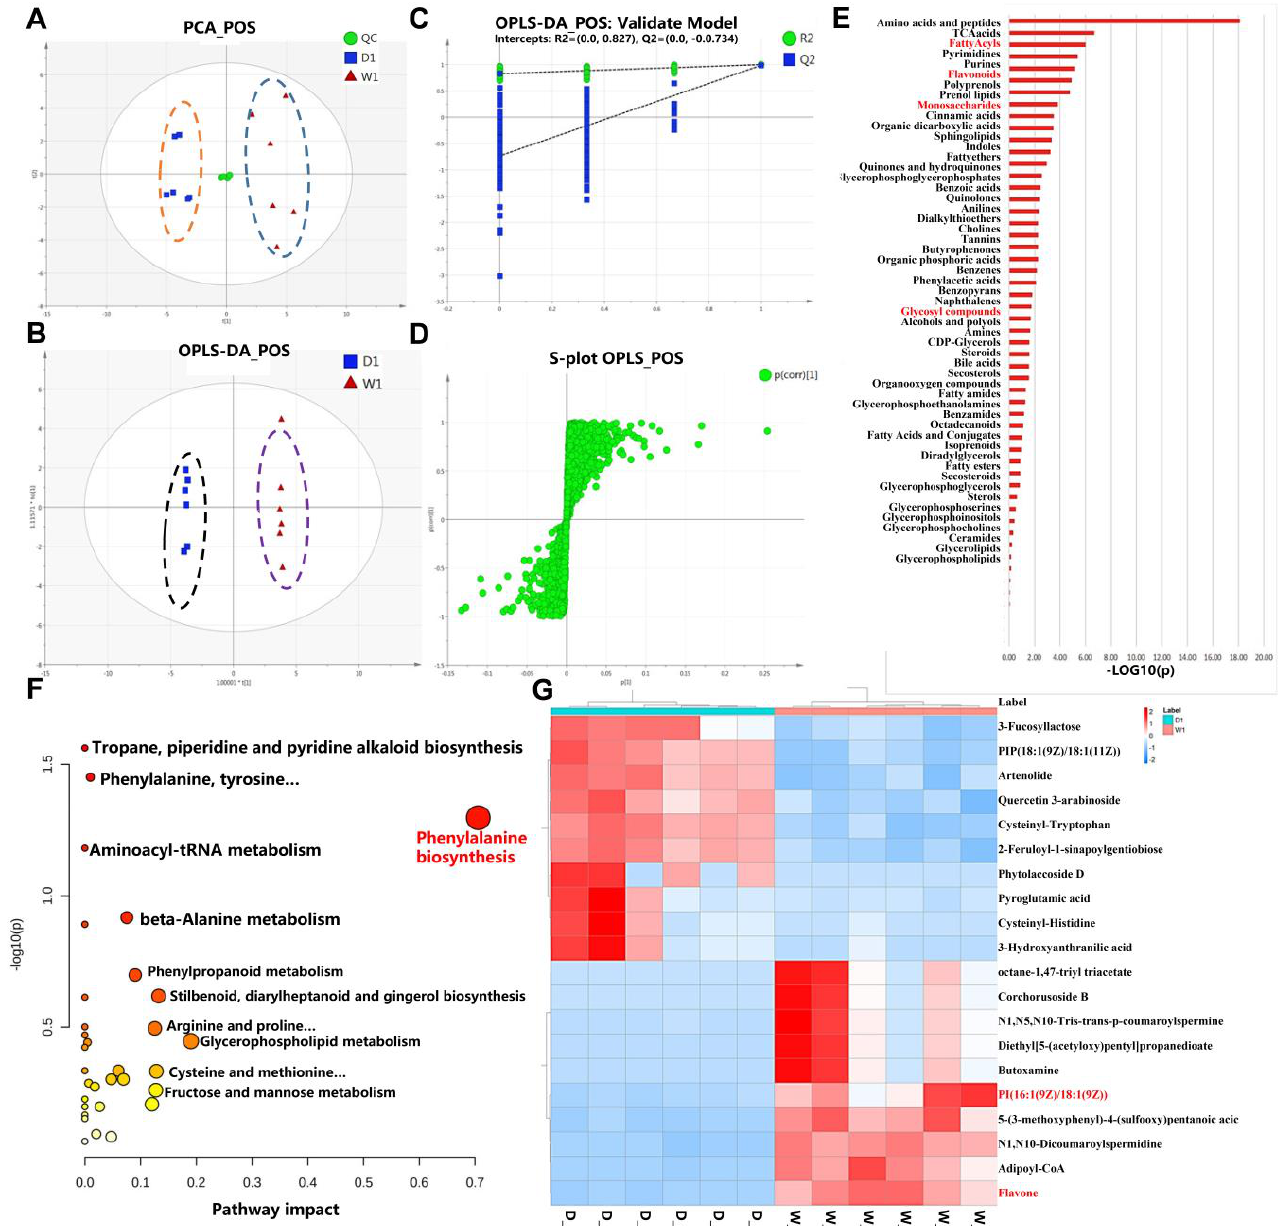
Figure 3. Untargeted metabolomics analysis of differential metabolites in inflorescences of WT and bhlh010 bhlh089 double mutant. ( A – D ) PCA, OPLS-DA analysis, and system stability investigation. PCA is an unsupervised model analysis method, and it can reflect the real difference among groups more reliably and eliminate outliers. ( A ) The overall PCA scores plots. The yellow dotted line is the bhlh010 bhlh089 (D1, blue square) double mutant inflorescence sample, and the blue dotted line is the WT (W1, red triangle) inflorescence sample. ( B ) OPLS-DA score plots. The black dotted line is the bhlh010 bhlh089 (D1) double mutant inflorescence sample, and the purple dotted line is the WT (W1) inflorescence sample. In the model of positive mode, R2X = 0.716, R2Y = 0.999, Q2 = 0.987. The model is thought to be reliable if these parameter values > 0.4. ( C ) OPLS-DA models were validated by permutation tests to access whether the modes were overfit. R2 = 0.827, Q2 = − 0.734. ( D ) S-plots of Group W1 and Group D1. The points far from the origin contribute to intergroup difference sig- nificantly and have lager VIP values. The above ( A – D ) horizontal and vertical coordinates have no practical significance. The above only shows the results of positive ion accumulation mode. ( E ) Clus- ter analysis of total differential metabolites. Differential metabolites were screened out by the VIP (variable importance in projection) value of the OPLS-DA model (VIP ≥ 1) and independent sample t -test ( p < 0.05). Adduct manner: [M+H] + and [M+Na] + were selected in positive mode, [M-H] − in negative mode. Mass error value: 30 PPM. ( F ) The bubble plot of significantly reduced metabolic